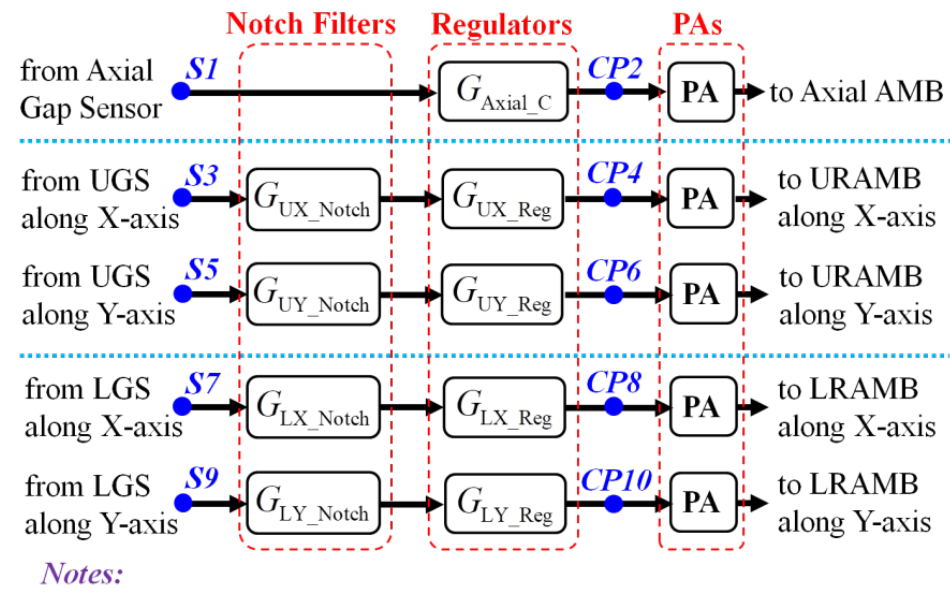
Figure 3. Internal view of ECU for TMP (Model: Osaka TD700/1100 ).